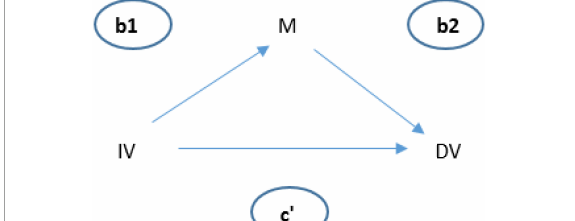
FIGURE1 Basic mediation model used.